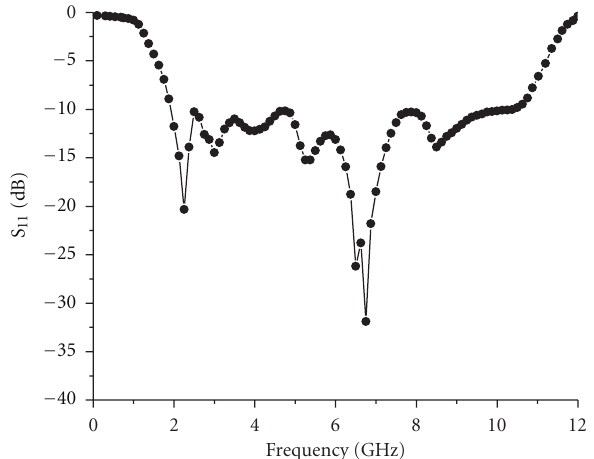
Figure 5: Simulated result of S 11 with slots (A + A (cid:2) ).